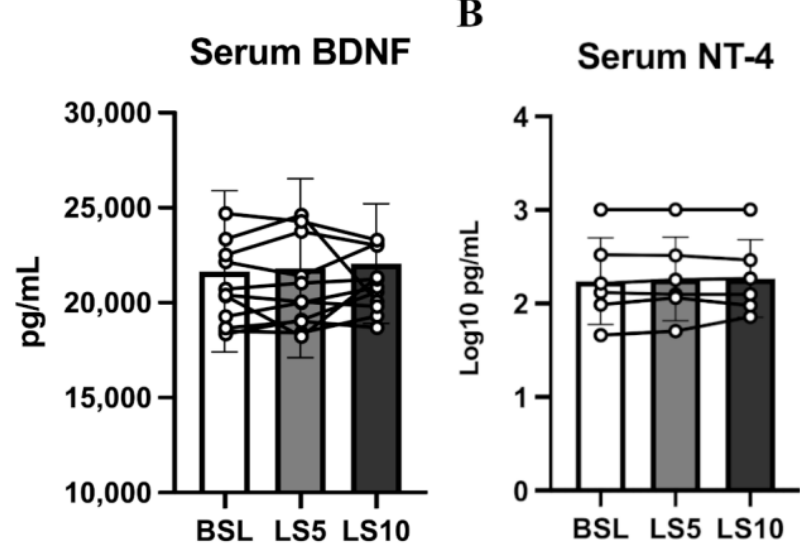
Figure 7. Serum neurotrophin levels were assessed at baseline, after 5 days of ULLS, and after 10 days of ULLS in ( A ) brain-derived neurotrophic factor and ( B ) Neurotrophin-4. Error bars represent standard deviations. All pairwise comparisons between time points were not statistically significant at p < 0.05. Experiments were performed in duplicates. n = 11 male subjects; one-way ANOVA. No significant changes at the transcriptional level in the TrkA, TrkB and TrkC mRNA levels were found, as reported by the transcriptomics data (Figure 8A). However, the pro- tein level of their receptor, TrkB, was halved (−45%; p = 0.035) (Figures 8B-8C and S7-S9).